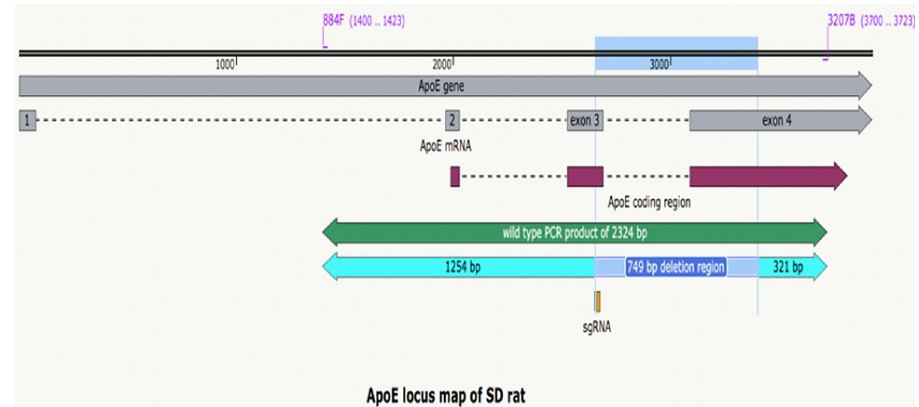
Fig 1. Detailed genetic map of the ApoE locus in this study. The ApoE gene of SD rats consists of one noncoding exon at the 5 0 terminal followed by three coding exons. One single guide RNA (sgRNA, position as indicated) induced deletion from exon 3 to exon 4 was introduced by pronuclear injection of CRISPR/Cas9 components in SD rat embryos. Founder No. 27 carries a 749 bp deletion and was designated as ApoE em1Narl (mutation indicated at the corresponding region). This results in a truncation of the ApoE protein from amino acid 59 to 175, and was chosen as the functional “null” mutant of the ApoE locus. Primers (884F and 3207B) are marked at the corresponding sites that led to a 2324 bp PCR product (1254 bp + 749 bp + 321 bp) in wild type rat, whereas the ApoE em1Narl mutation resulted in a 1575 bp product (1254 bp+ 321 bp) that is present in the genotype of every